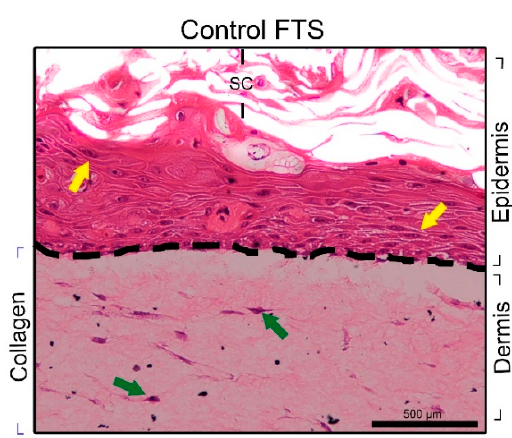
Figure 3. Photomicrographs of histological analysis—H&E staining (sample in paraffin) of the control FTS (USP-FTS). Fibroblasts (shown by green arrows) and keratinocytes (shown by yellow arrows) seeded on collagen. The histology of the control had shown quite delimited dermis and epidermis (shown by black dotted lines). SC: stratum corneum. Bar = 500 μ m.